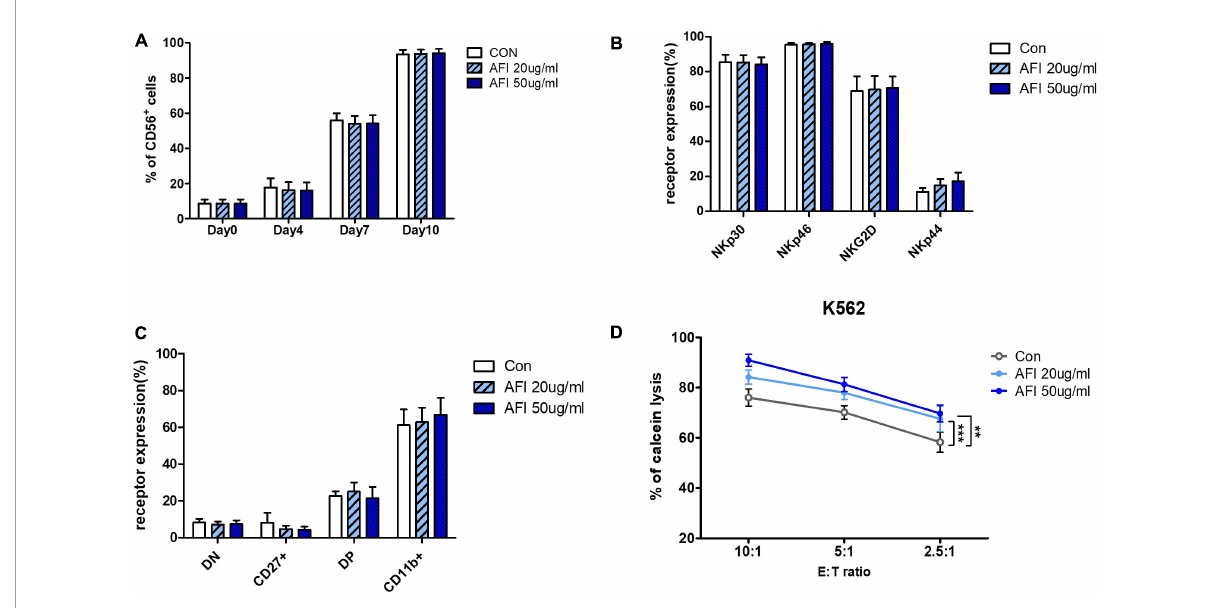
FIGURE4 Effect of Aurantii Fructus Immaturus (AFI) on differentiation of NK Cells from HSCs. (A) Differentiation of NK cells was checked on days 0, 4, 7, and 10 after AFI treatment in NK cells. (B) Expression of NK activating receptors were analyzed by flow cytometry and graph was shown as mean values of expression percentage for three independent experiments. (C) Flow cytometry analysis of CD27 and CD11b expression was performed in gated CD56 + NK cells differentiated from CD34 + cells (hematopoietic stem cell marker) isolated from umbilical cord blood with and without AFI. The CD56 + NK cells were divided into four subsets based on the differential expression of CD27 and CD11b; double negative, CD27 + CD11b-, double positive, and CD27-CD11b+. (D) NK cells were differentiated in either the absence (empty) or presence of 50 µ g/ml (sky blue) or 100 µ g/ml (blue) of AFI for 10 days and cytotoxicity against K562 cells was examined. Bars represent the mean ± SEM of three independent experiments ** p < 0.01 and *** p <